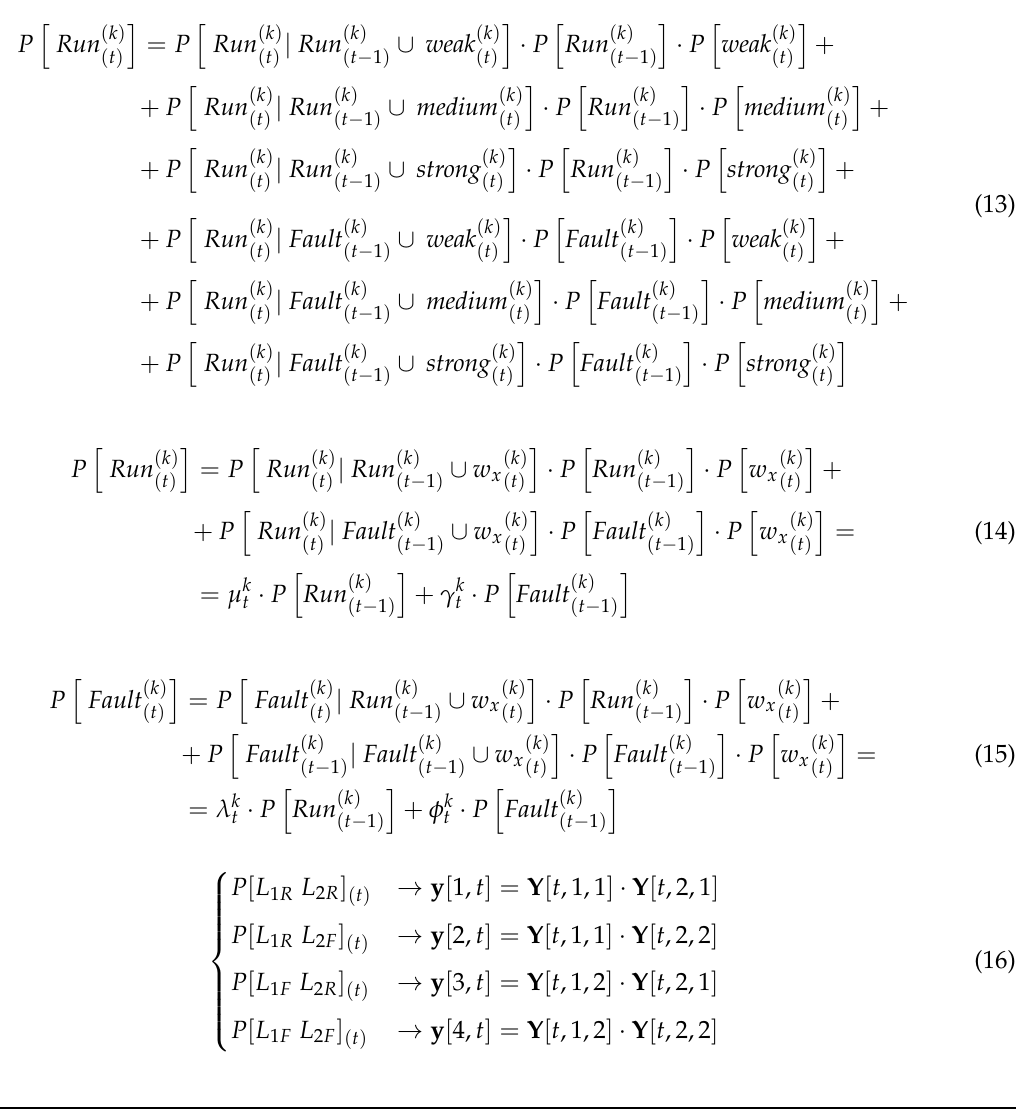
Algorithm 1 Network state probabilities